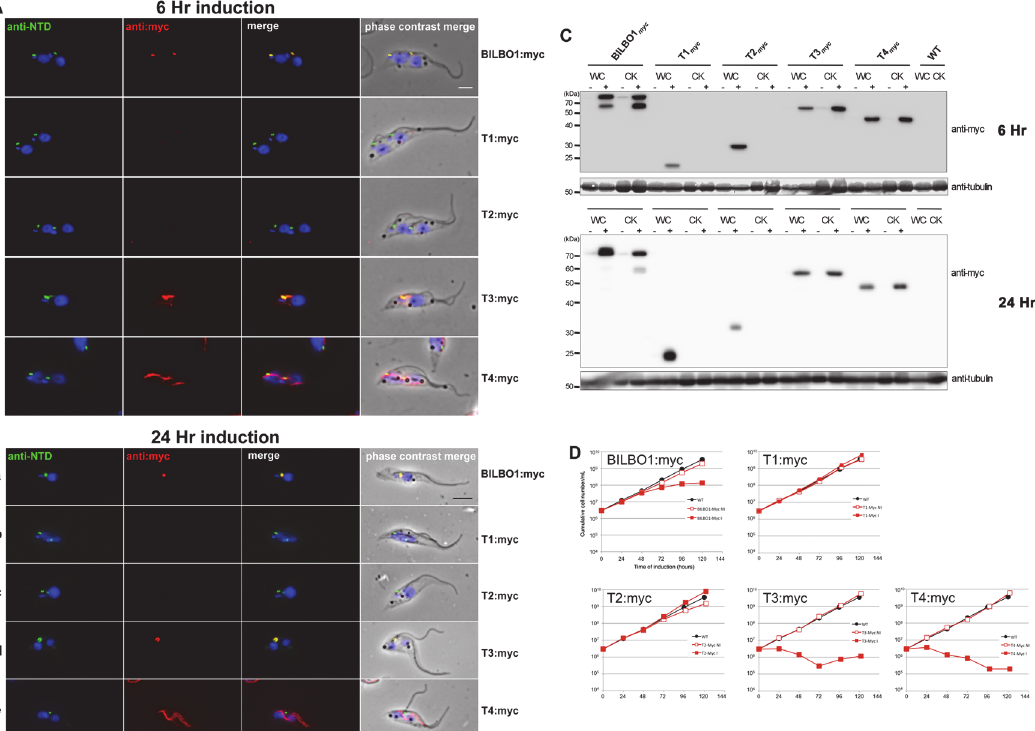
Fig 6. The coiled-domain is required for polymer formation in T. brucei . (A) Immunofluorescence labelling of cytoskeletons from cells expressing BILBO1:myc, T1:myc, T2:myc, T3:myc and T4:myc using anti-NTD (green) and anti-myc (red) after six hours of induction. (B) Immunofluorescence labelling of cytoskeletons expressing BILBO1:myc, T1:myc, T2:myc, T3:myc and T4:myc using anti-NTD (green) and anti-myc (red) after 24 hours of induction. (C) Western-blot of corresponding cells. 2.10 6 non-induced (-) or induced (+) for six hours from whole cells (WC) or cytoskeletons (CK) were loaded on a 12% SDS-PAGE, transferred and immuno-probed with anti-myc, or anti-tubulin (tubulin is a loading control). WT is the non-transfected parental cell line. (D) Growth curves of the parental cell line (WT, black circles) compared to the cell lines non-induced (NI, red open squares) or induced (I, red closed squares) for the expression of BILBO1, T1, T2, T3, T4 myc-tagged truncations. Scale bars in A and B represent 5 μ